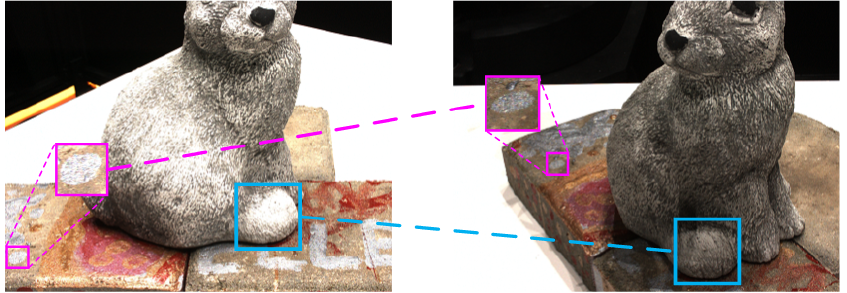
Figure 2. Ambiguity when adopting photometric